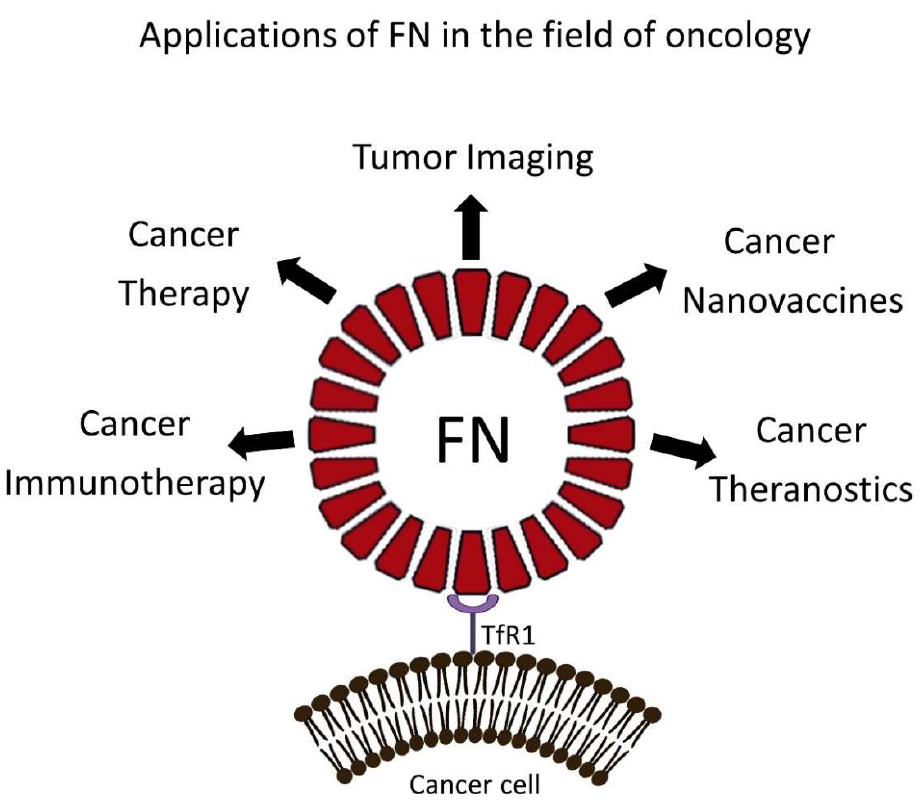
Figure 2. Applications of FNs in the field of oncology. FNs are versatile drug delivery systems. They can be loaded simultaneously with anticancer and imaging agents to provide effective antitumor therapy that can be monitored by different imaging modalities. In addition, FNs can be loaded with immunomodulatory drugs to remodel the TME or can be developed to incorporate tumor associated antigens to induce specific adaptive immune responses against cancer cells, in the case of nanovaccines. This cartoon was created by using BioRender (https://biorender.com/, accessed on 2 November 2021).